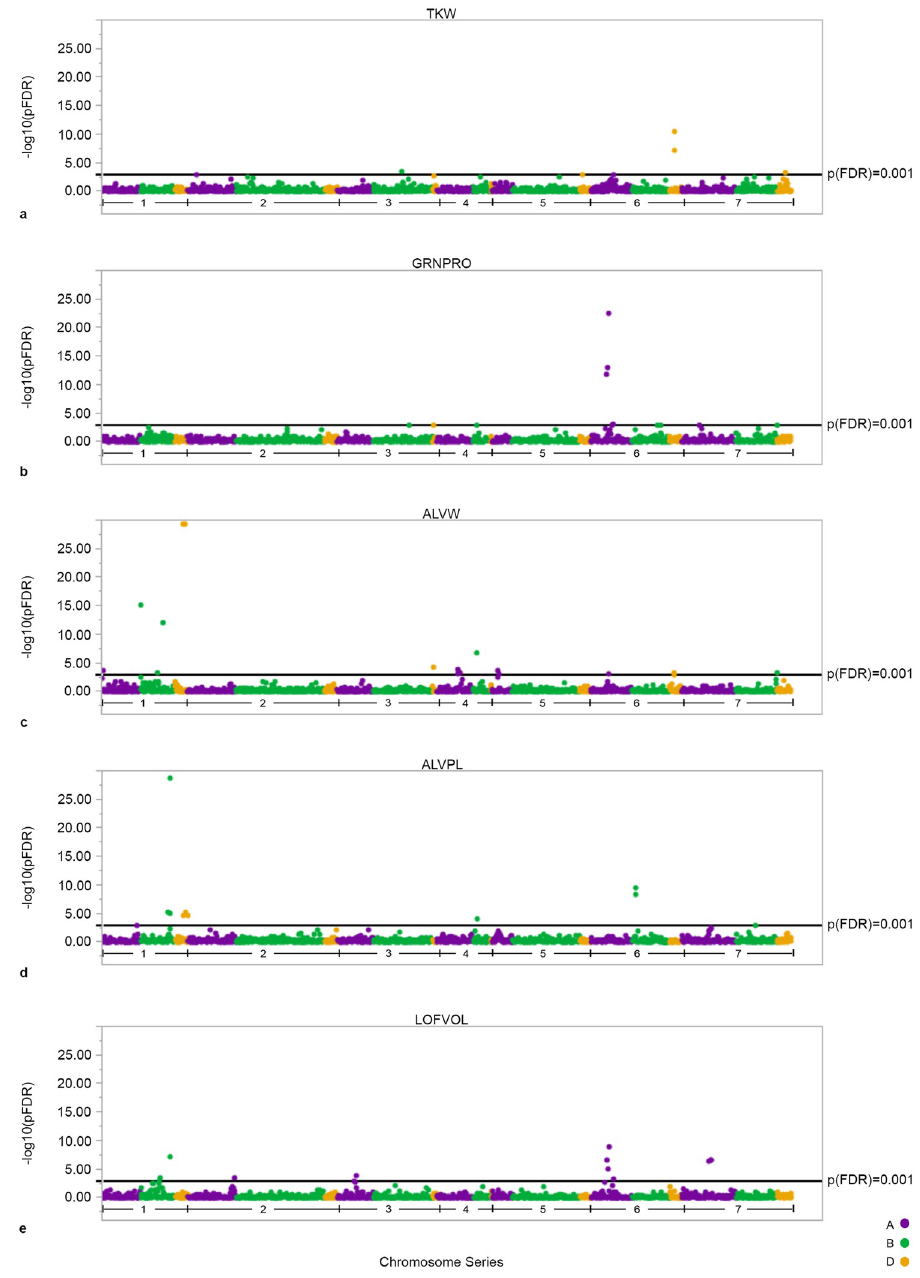
Fig 3. Manhattan plots of thousand kernel weight (TKW), grain protein (GRNPRO), Alveograph W (ALVW) and P/L (ALVPL), and loaf volume (LOFVOL) traits. Homeologous chromosomes are identified by number, and color separates the genome where purple is A, green is B, and yellow is